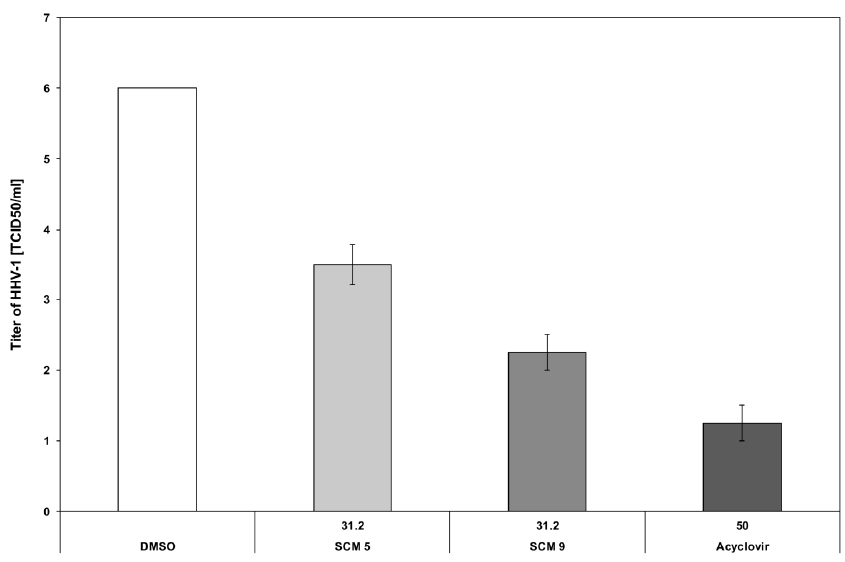
Figure 5. The virus-inhibiting properties of SCM compounds against human HHV-1 in A-549 cell line. A-549 cells were infected with HHV-1 and after 1h of virus absorption at 37 was removed and the infected cells were incubated for 48 h with SCM5 , SCM9 compounds (31.2 µ M) and DMSO as the solvent control. Acyclovir (50 µ M) was used as a reference drug. The viral titer was expressed with reference to the TCID 50 value, which is based on the cytopathic e ff ect caused by this virus in approximately 50% of infected cells. The results, which were obtained from quadruplicate determinations (mean ± SE), are presented as the log 10 TDIC50 / mL values in relation with appropriate DMSO control. The level of virus was defined according to the requirements presented in PN-EN 14476:2013 +